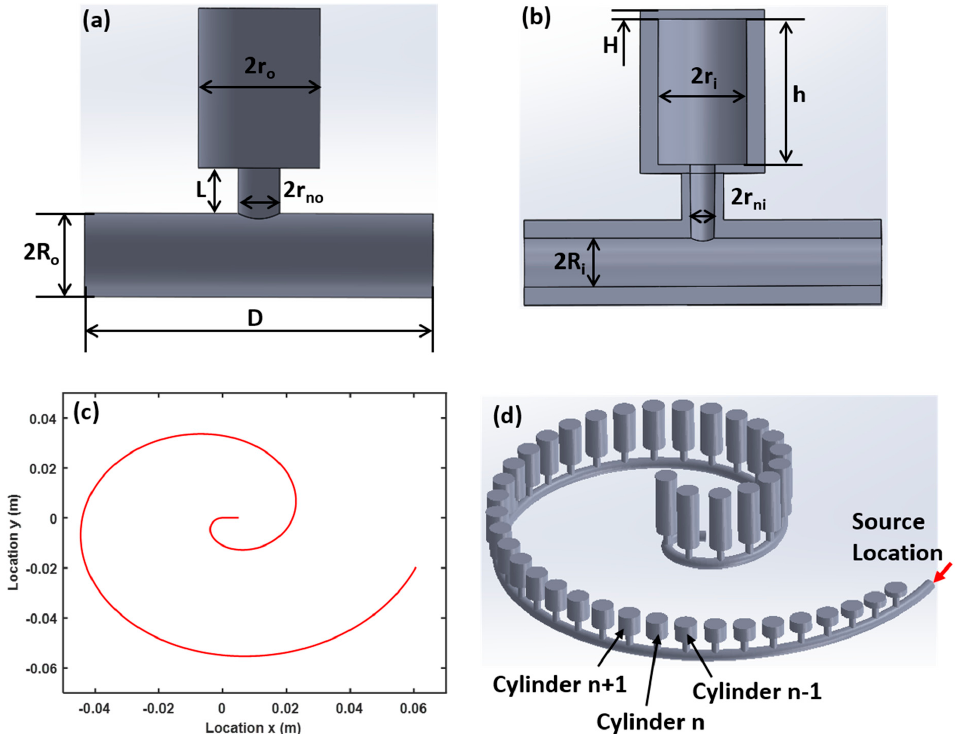
Figure 1. Schematic illustration of the cochlear-inspired structure. ( a ) Front view of Helmholtz resonator unit cell. ( b ) Cross-sectional view of the Helmholtz resonator unit cell showing the hollow interior of the cylinder and spiral tube. ( c ) Archimedean spiral and ( d ) isometric view of the entire structure.